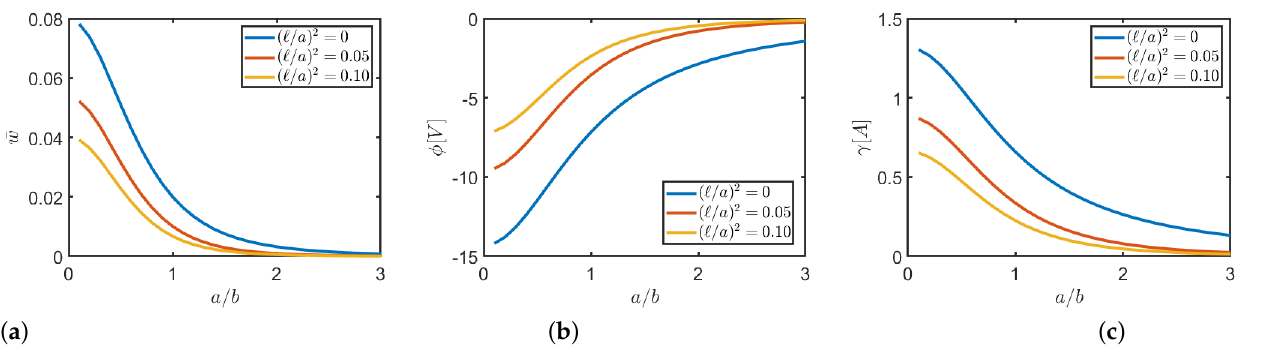
Figure 3. Graphs of displacement ¯ w ( a ) electric φ ( b ) and magnetic γ ( c ) potential, in the point ( a /2, b /2 ) to vary of a / b ratio and for different values of nonlocal parameter ( (cid:96) / a ) 2 and for n p = 1 (SDL; q = 10 3 N/m 2 , T 0 = T 1 = 0 K, ρ E = 0 C/m 2 , ρ H = 0 Wb/m 2 ).